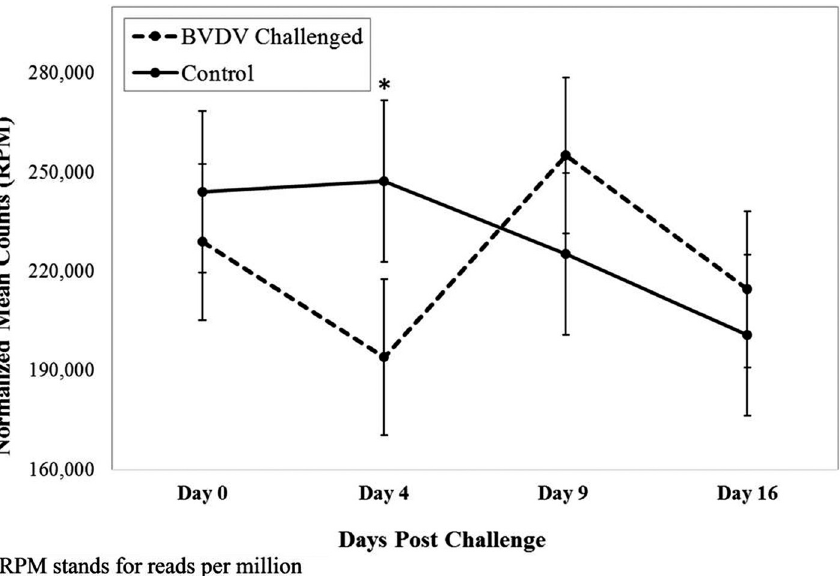
Figure 1 - Interaction of time by treatment for 5’ tsRNA GlyCCC ( p = 0.03). Dashed line corresponds to cattle challenged with bovine viral diarrhea virus (BVDV). Solid line corresponds to control animals. Error bars represent standard error bars of the normalized means. An asterisk above a time point rep- resents a significant ( p = 0.01) difference in number of read counts between BVDV challenged and control animals at that time point.